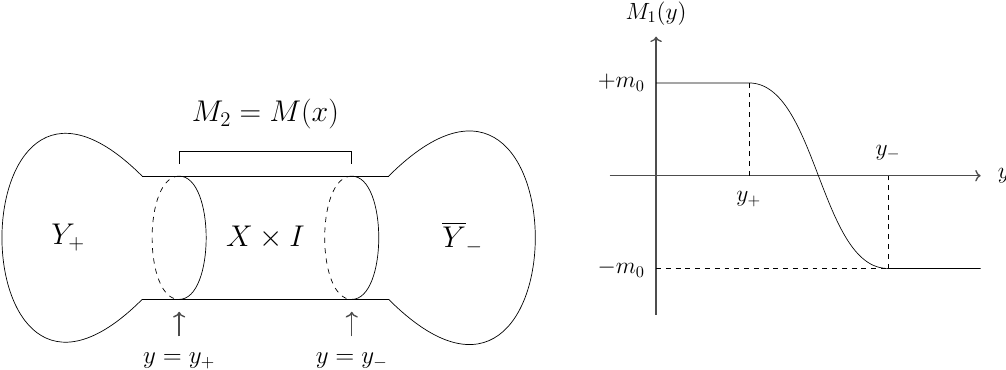
Figure 1 . (Left) The ( d + 1) -dimensional closed manifold Y = Y − ∪ the auxiliary ( d + 1) -dimensional theory is defined. (Right) The profile of M 1 ( y ) along the collar neighborhood of X in Y forms an interface. On the interface, the original d -dimensional theory of interest appears as a collection of localized